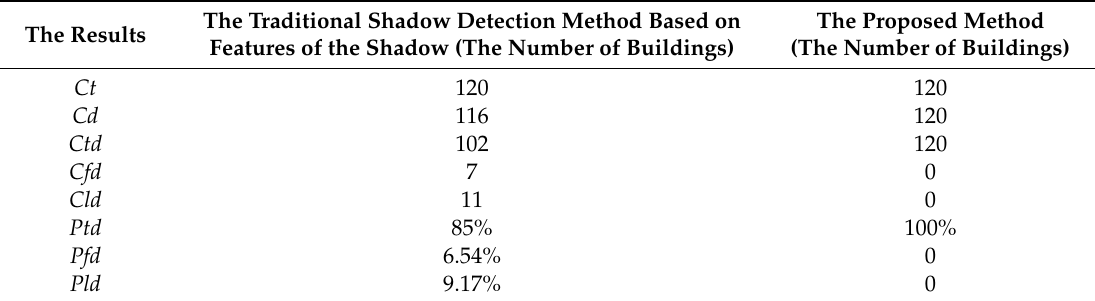
Table 3. Comparison of detection accuracy by two